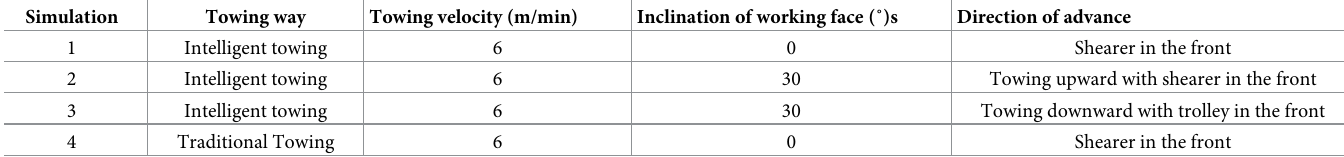
Table 2. Parameters of four different working conditions.